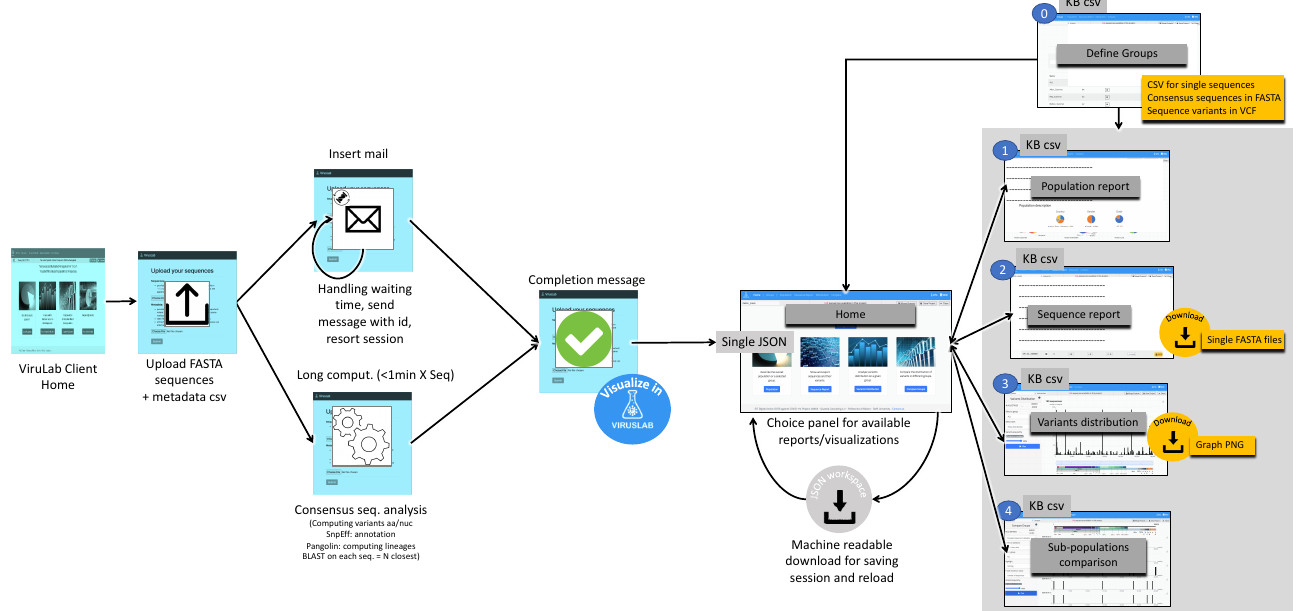
Figure 4. Interaction workflow for VirusLab